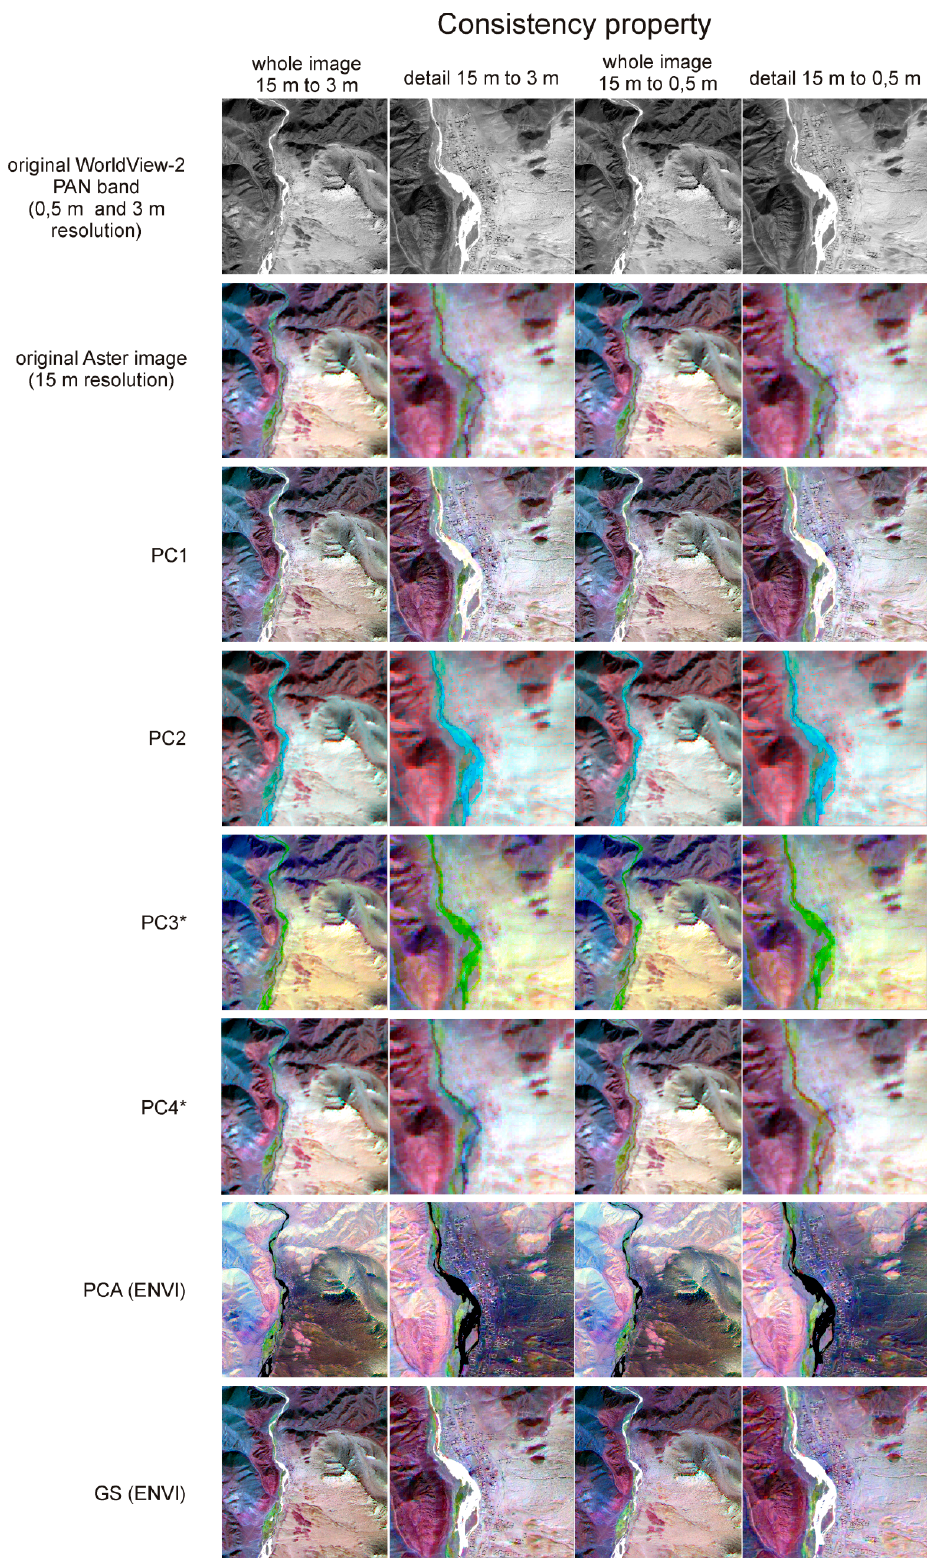
Figure 7. Fused images compared to the original ASTER image at both 3.0-m and 0.5-m spatial resolutions. It was expected that the first two PCs have the potential to give good results when employing the PCA sharpening process, however PC3* and PC4* were used to compare the result and explain it in a wider context.